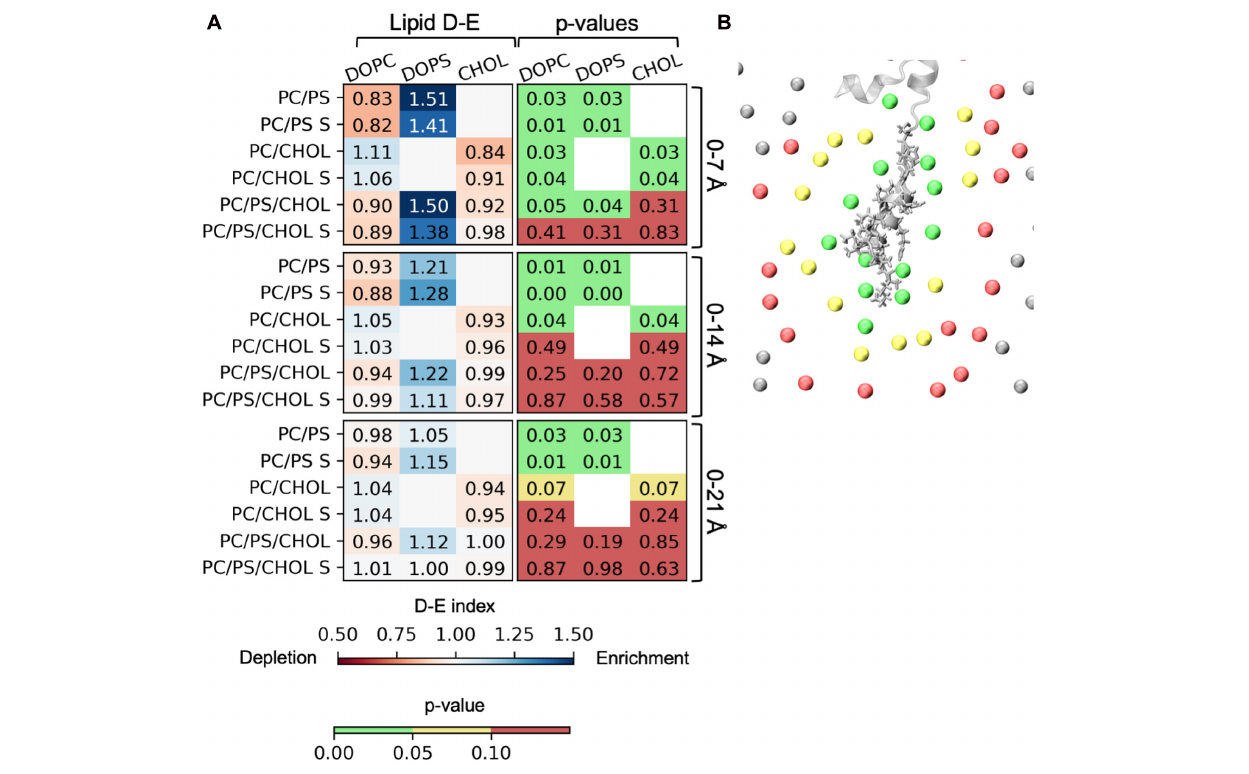
FIGURE 9 | Depletion enrichment index (D-E index) of lipids around the peptide. (A) The panels represent the D-E index of the lipids within 7, 14, and 21 Å. The first column shows the values of the D-E index, colored on a scale from 0.5 to 1.5. The second column shows the p -values. The statistical significance was evaluated using the single sample T -test, with 1 as the null-hypothesis, indicating that there is no enrichment or depletion of a given lipid type around the peptide. (B) The phospholipid phosphates within 7 Å (green), 14 Å (yellow), and 21 Å (red) of IAPP 1 - 19 . The D-E index is calculated for each simulation series, and the simulation series with IAPP starting in the straight conformation are denoted with an